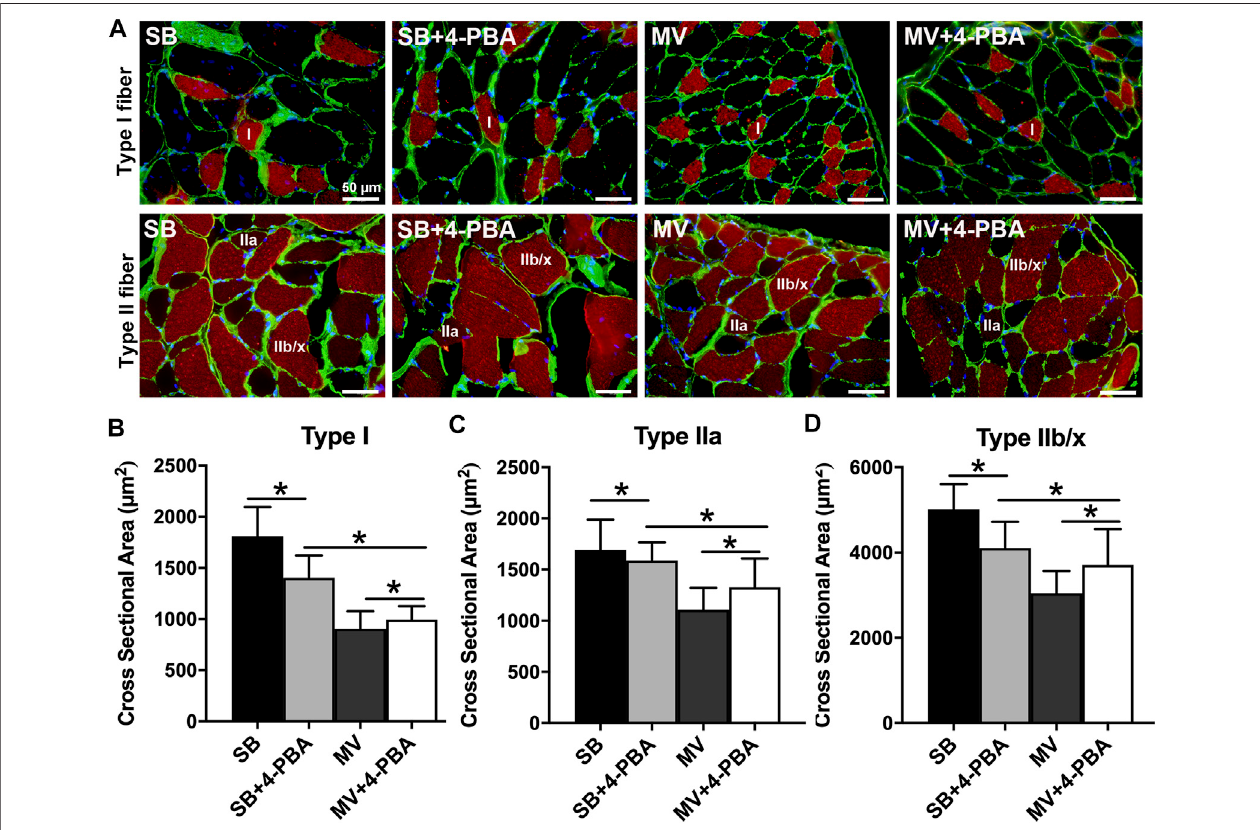
FIGURE 3 | Inhibition of ER stress by 4-PBA reduces diaphragm atrophy during MV. (A) Representative immuno fl uorescence staining images of diaphragm myo fi bers. (B – D) The administration of 4-PBA (ER stress inhibitor) reduced the CSAs of diaphragm myo fi bers in rats subjected to SB. In contrast, the cross-sectional areas (CSAs) of myo fi bers in the MV + 4-PBA group were signi fi cantly higher than those in the MV group. * p < 0.001 (ANOVA followed by the Tukey HSD test, n = 6 per group). MV = mechanical ventilation; SB = spontaneous breathing; 4-PBA =